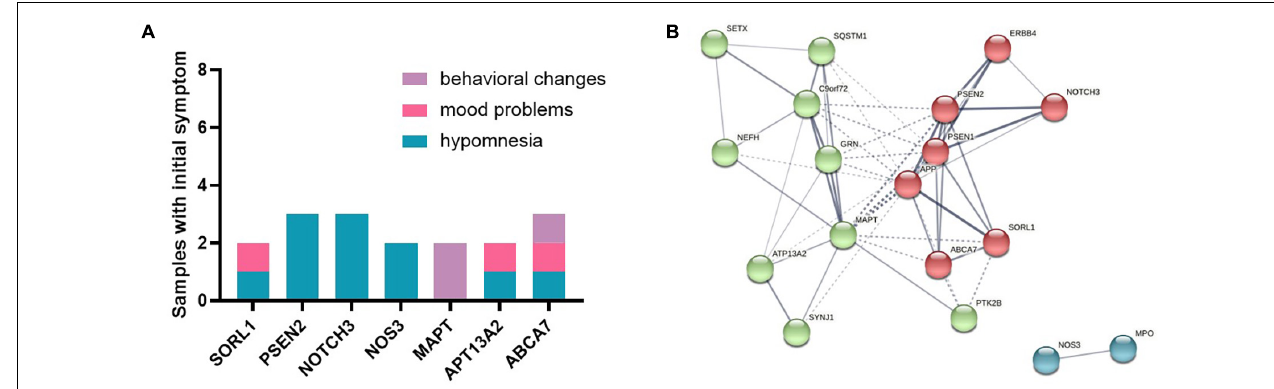
FIGURE 2 | (A) Initial symptoms of patients with variants in SORl1 , PSEN2 , NOTCH3 , NOS3 , MAPT , APT13A2 , and ABCA7 genes (samples n ≥ 2). (B) The protein–protein interaction (PPI) network showed that there were three clusters among all proteins based on the K-means clustering algorithm.